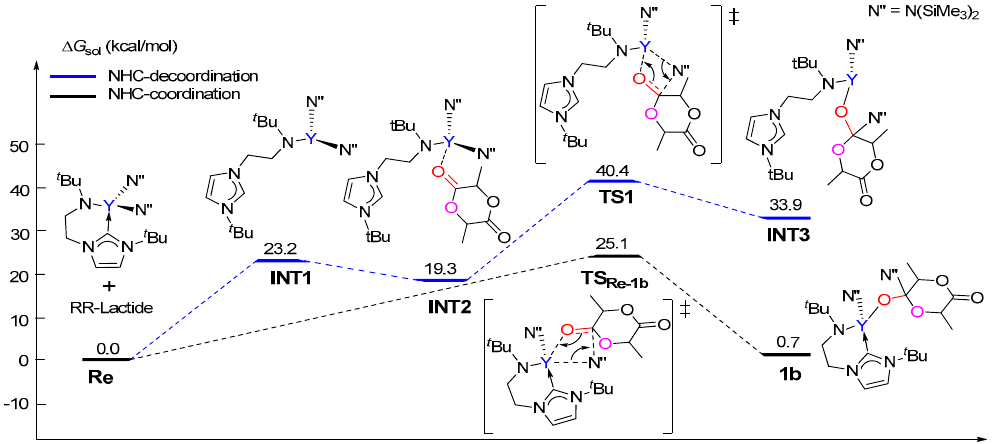
Figure 4. Calculated free energy profiles for the insertion of the ( R , R )-lactide monomer in the cases of NHC de-coordination and coordination.